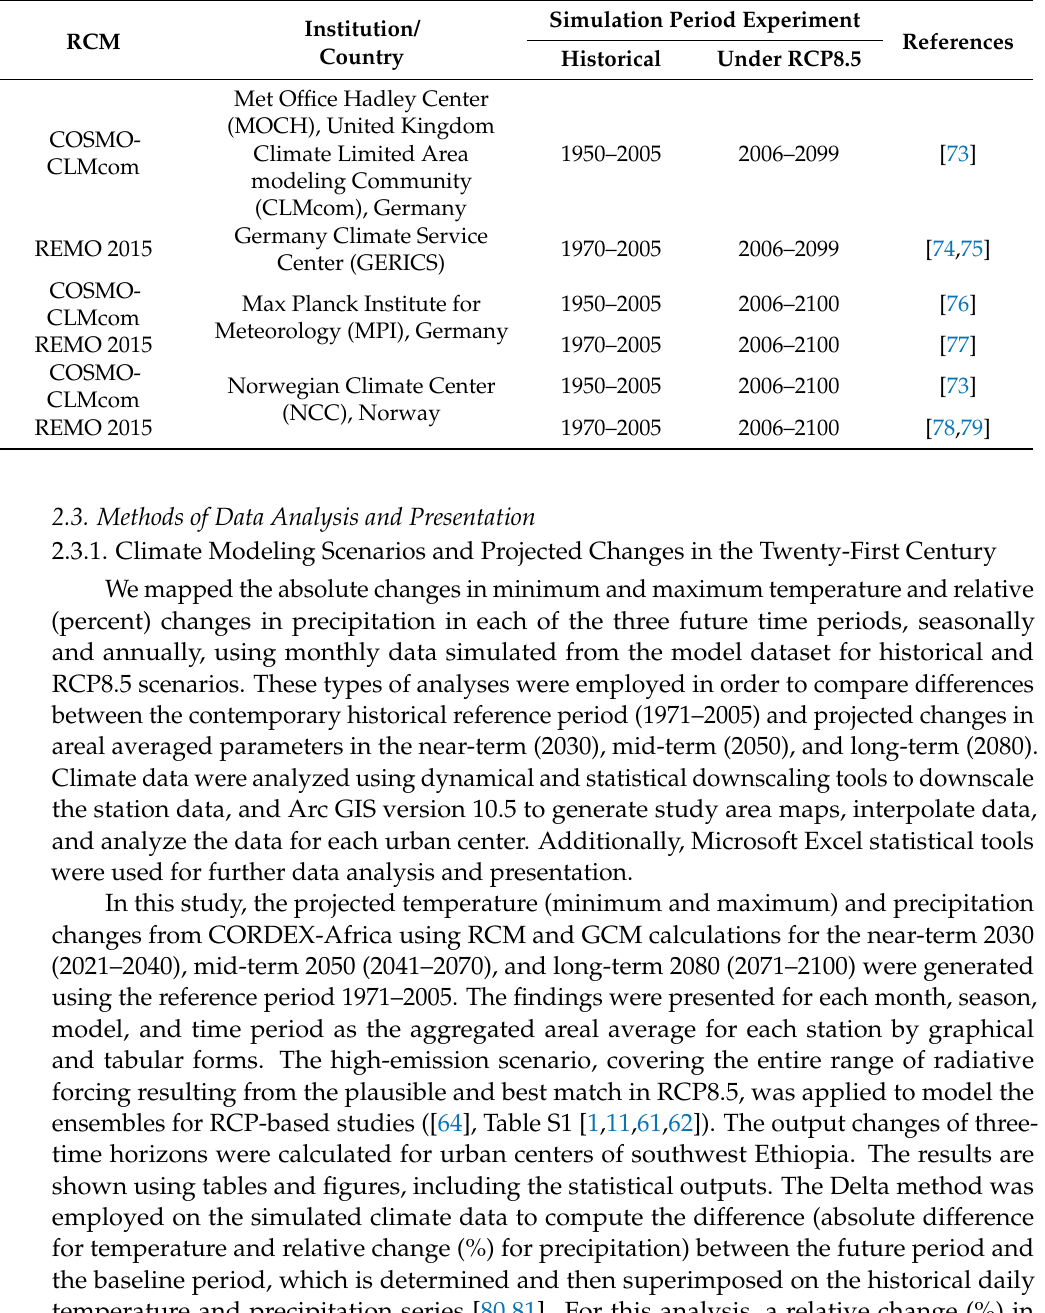
Table 1. List of climate model simulations used in the analysis of the minimum and maximum temperature and precipitation in the study area. Each experiment comprises one historical and one projected scenario (RCP8.5) run, spanning the historical period 1950–2005 and the projected period 2006–2100. The horizontal resolution of all simulations is 0.22 ◦ in both latitude and